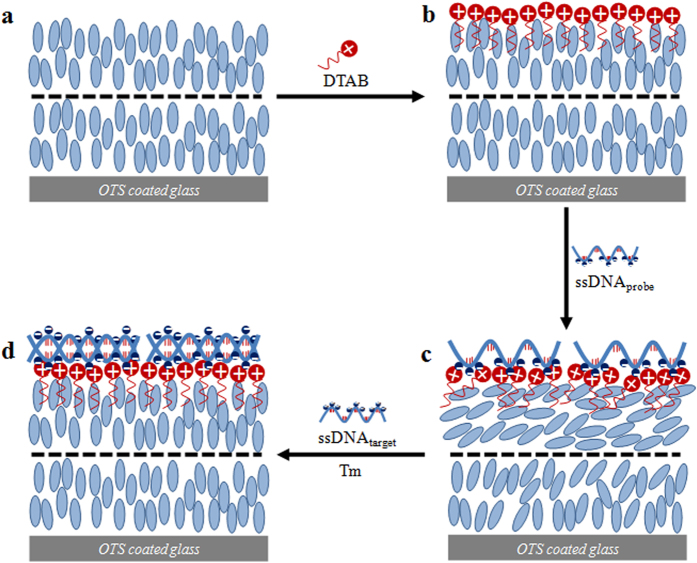
Stepwise assembly of the TEMDTAB/DNA: (a) E7 filled in a TEM grid placed on the OTS-coated glass, (b) TEMDTAB, (c) TEMDTAB/DNA, and (d) after hybridization of ssDNAprobe with ssDNAtarget. OTS, octadecyltrichlorosilane; TEMDTAB/DNA, liquid-crystal-filled transmission electron microscopy grid coated with dodecyltrimethylammonium bromide (DTAB) and ssDNA probe.